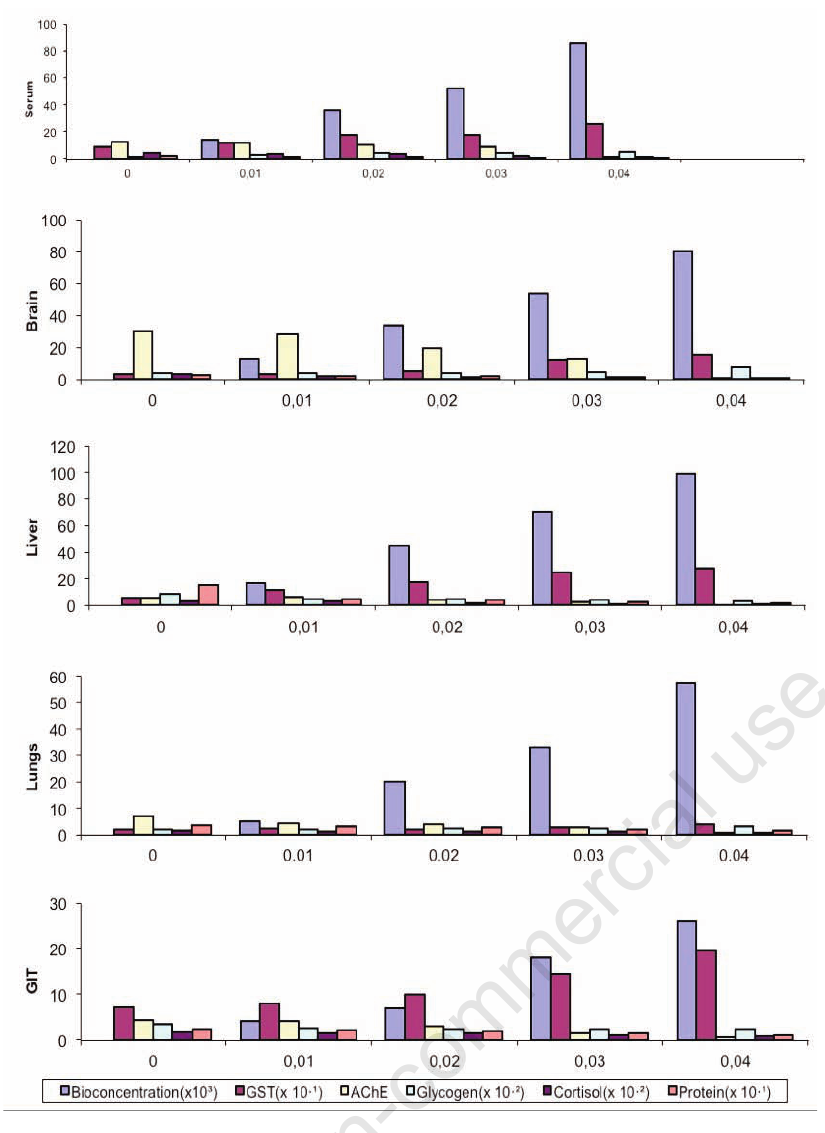
Figure 4. Toxicity comparisons between bioaccumulation and alteration in biochemical indices of adult Bufo regularis exposed to diazinon